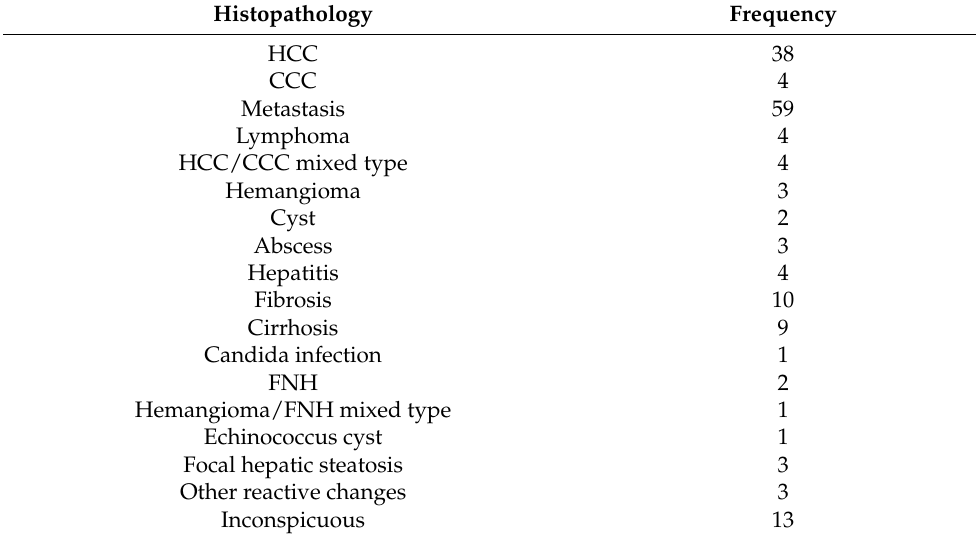
Table 1. Histopathological results.